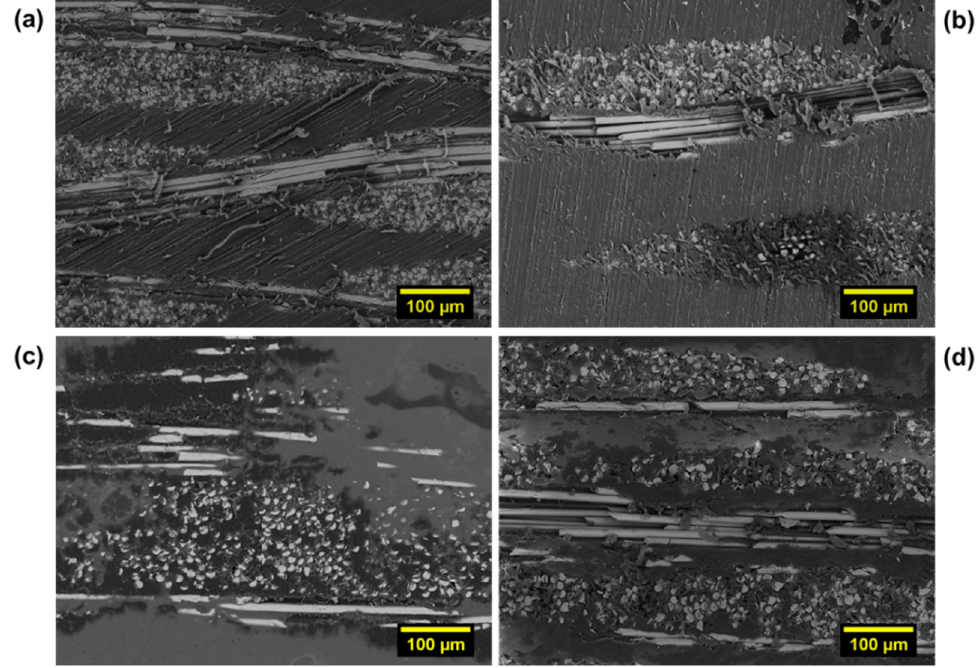
Figure 10. Representative SEM micrographs (magnification: 300×) of cryo-fractured surfaces: ( a ) Plain_TL, ( b ) Plain_P40, ( c ) Twill_PL, and ( d ) Twill_P40.